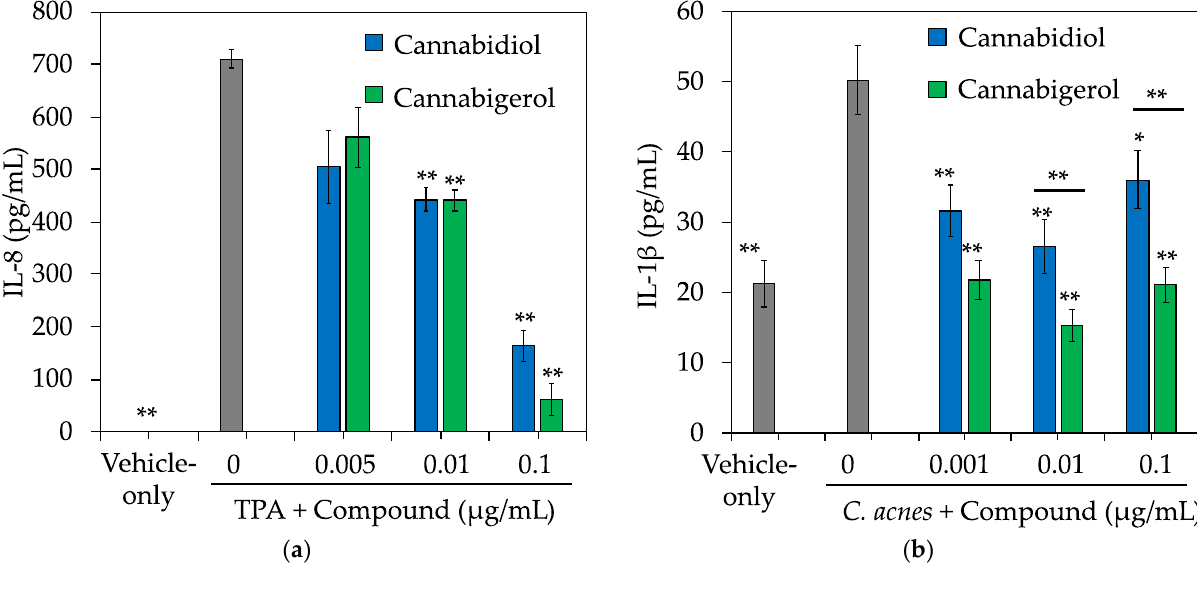
Figure 2. CBG and CBD protect against chemical and bacteria-induced inflammation. Primary NHEKs were cultured in the presence of CBD or CBG for 1 h. Later, cells were co-treated with compounds and 5 ng/mL TPA or 1 × 10 7 CFU C. acnes (ATCC ® 6919™) for 24 h. Media supernatants were collected after 24 h and analyzed by ELISA for ( a ) Interleukin-8 (IL-8) or ( b ) Interleukin-1β (IL-1β). Data represent mean ± SE from three independent experiments. * p < 0.05; ** p ≤ 0.01 relative to inducer + vehicle group.